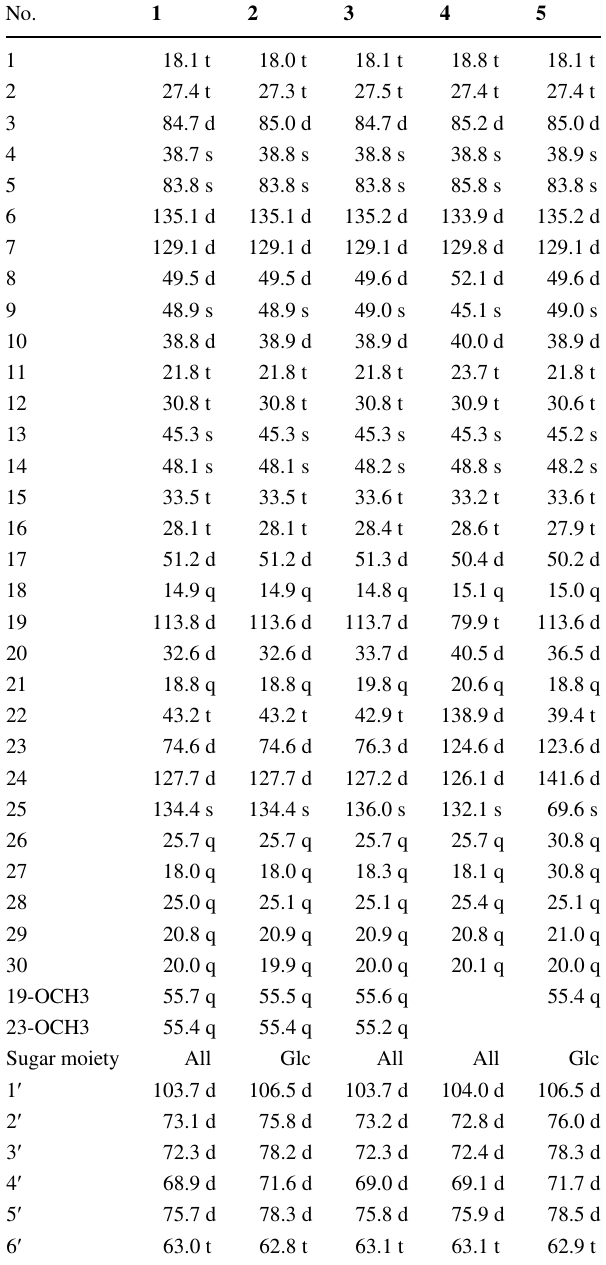
Table 2 13 C (150 MHz) NMR spectroscopic data of compounds 1 – 5 in pyridine-d5 [δ in ppm]